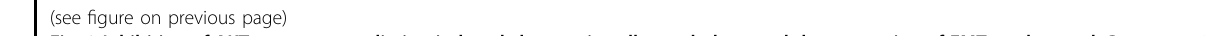
Fig. 3 Inhibition of AKT attenuates radiation-induced changes in cell morphology and the expression of EMT markers. a , b Representative western blots and densitometric quanti fi cation of phosphorylated AKT on both S473 and T308 at different times and with different radiation doses. c Immuno fl uorescence staining for p-AKT (green) and DAPI staining (blue) in nonirradiated control and irradiated cells at 1 h postirradiation. Scale bar represents 50 μ m. d – f RLE-6TN cells were incubated with/without the selective AKT inhibitor PF-04691502 for 2 h before irradiation with 8 Gy. d , f Western blot analysis of p-AKT, E-cadherin, vimentin, and α -SMA expression at 1 or 48 h postirradiation. e Phase contrast microscopy images of cells at 48 h after treatment with 8 Gy irradiation. Scale bar represents 100 μ m. All the above western blot analyses use GAPDH or AKT as the loading control. The data are presented as the mean ± SEM ( n = 3). * P < 0.05, ** P < 0.01, and *** P < 0.001 vs. nonirradiated